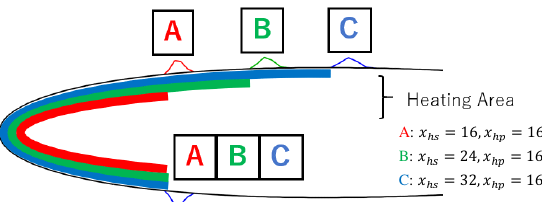
Figure 11. Formed ice shapes for three heating cases. Heating areas are displayed by the bold line with the same case index color.